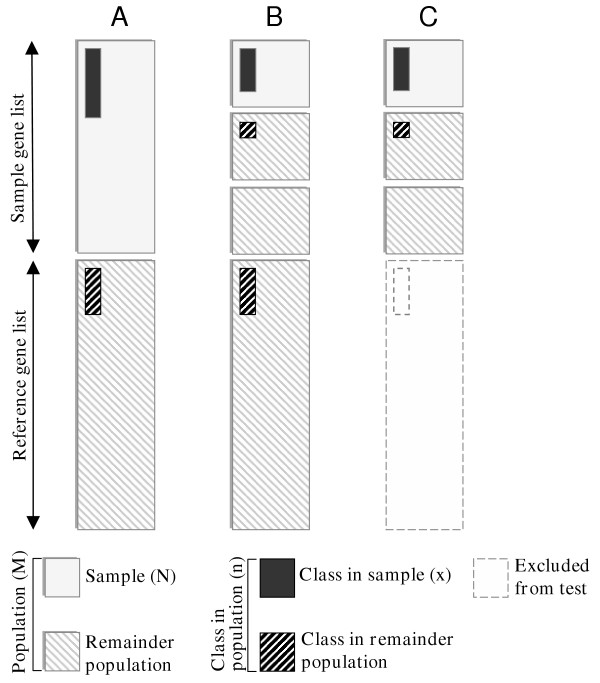
The measures for studying over-representation of classes. Over-representation of classes is measured by using A) the whole sample gene list as a sample and the reference gene list as a remainder population, O.log(p); B) a single cluster as a sample and the rest of the sample gene list and the reference gene list as a remainder population, C.log(p); and C) a single cluster as a sample and the rest of the sample gene list as a remainder population excluding the reference gene list, S.log(p). In each situation, Fisher's exact test f(x, M, n, k) [16] is used to determine the over-representation. O.log(p) presents the original over-representation of sample gene list without clustering. C.log(p) highlights the classes that are over-represented in the original sample gene list and in individual cluster. S.log(p) reports the contribution to the formation of cluster structure.